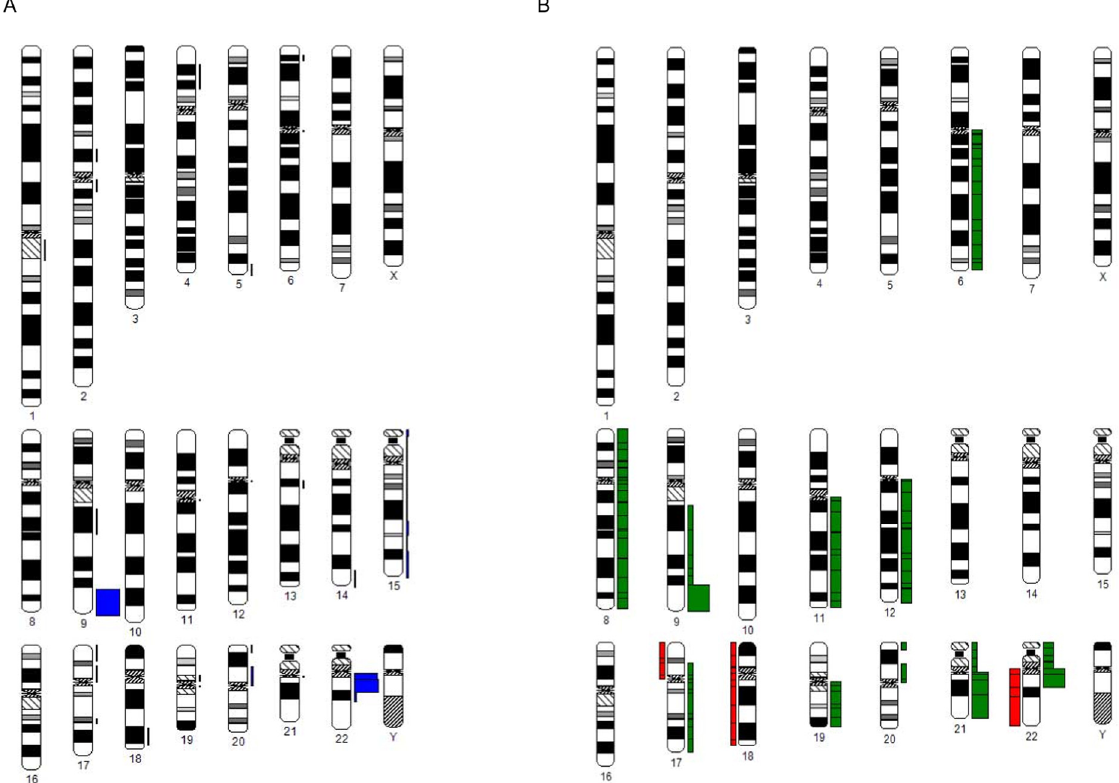
Figure 1. ( A ) Chromosomal distribution of cytogenetic breakpoints at diagnosis in all patients with additional non-Philadelphia aberrations (nPhAs) (cytogenetic data analysis System CyDAS). ( B ) Chromosomal distribution of gains (shown right of the chromosome in green) and losses (shown left of the chromosome in red) at diagnosis in all patients with additional non-Philadelphia aberrations (nPhAs) (cytogenetic data analysis System CyDAS). Table 2. Individual characteristics of n = 21 patients with variant translocations (VT), additional chromosomal aberrations (ACA) and complex karyotype (CK). A minimum of 15 metaphases were analyzed in each patient.